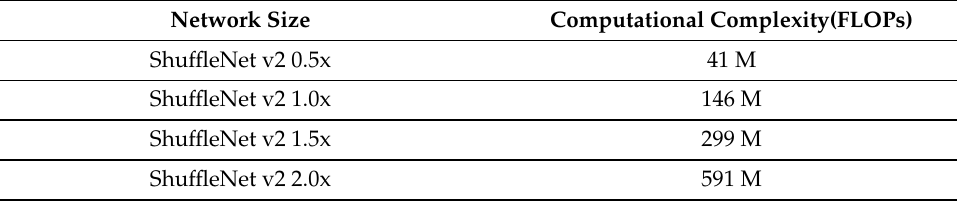
Table 1. Computational complexity of ShuffleNet v2 with different sizes [30].